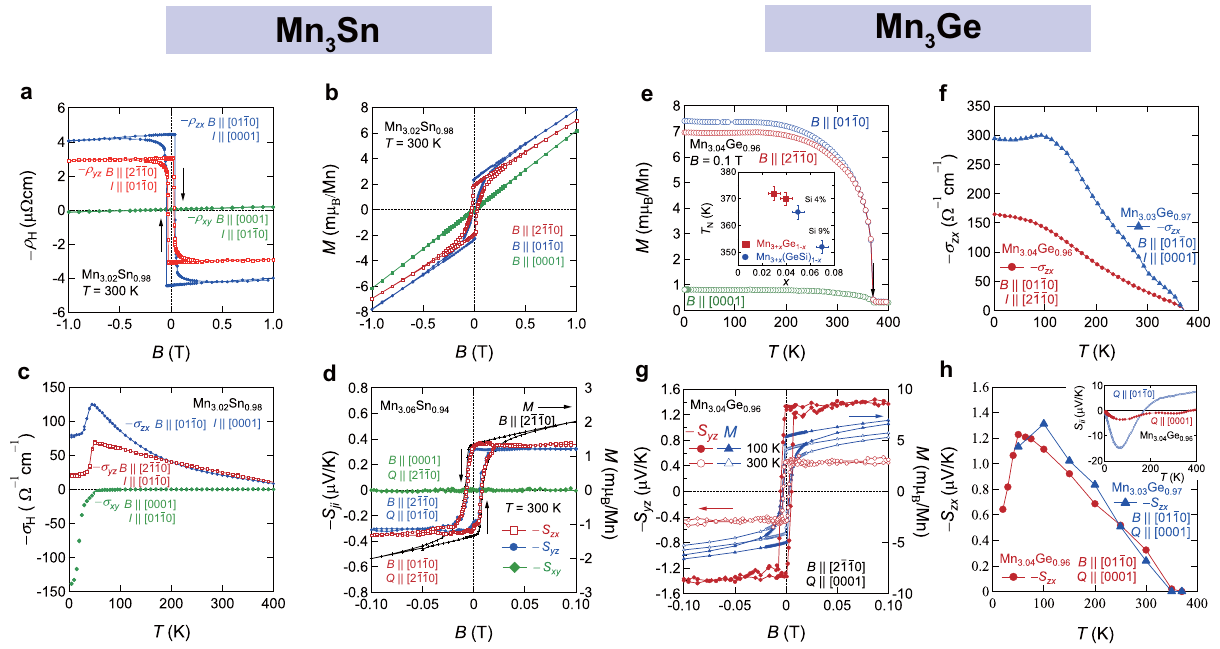
Fig. 2 Observation of large anomalous Hall and Nernst effects in Mn 3 Sn. a Field dependence of the Hall resistivity, ρ H ( B ), observed in Mn 3.02 Sn 0.98 at (cid:1) (cid:3) (cid:1) (cid:3) room temperature under magnetic fi elds B k 2 (cid:1) 1 (cid:1) 10 , 01 (cid:1) 10 , and [0001]. b Anisotropic behavior of the magnetization M of Mn 3.02 Sn 0.98 observed at room temperature for the three different fi eld directions. c Temperature dependence of the zero- fi eld Hall conductivity, σ H ( B = 0), in Mn 3.02 Sn 0.98 . d Anisotropic (cid:1) (cid:3) fi eld dependence of the Nernst coef fi cient − S ji of Mn fi eld dependence of the magnetization M for B k 2 (cid:1) 1 (cid:1) 10 (right axis) is shown (cid:1) 3.06 Sn 0.94 (left axis). The for comparison. e Temperature dependence of the magnetization M of Mn 3.04 Ge 0.96 obtained at B = 0.1 T along 2 (cid:1) 1 (cid:1) 10 respectively. The magnetization is strongly anisotropic, such that the ratio between the in-plane and out-of-plane M reaches about 10 in the low- temperature region. This feature is expected for the coplanar magnetic structure. Inset: the variation of the Néel temperature T N as a function of the Mn concentration x . The red and blue symbols represent T N values obtained in Mn 3 + x Ge 1- x and Mn 3 + x (GeSi) 1- x , respectively. f Temperature dependence of the (cid:1) Hall conductivity, − σ zx , observed in Mn 3.03 Ge 0.97 and Mn 3.04 Ge 0.96 . g Anomalous Nernst coef fi cient, − S yz ( B ) (left axis) vs. B obtained for B k 2 (cid:1) 1 (cid:1) 10 Q || [0001], at 100 and 300 K. The isothermal magnetization M curves (right axis) are also shown at the same temperatures, which exhibit approximately the same coercivity fi eld of about 80 Oe as in − S yz ( B ). h Temperature dependence of the zero- fi eld Nernst coef fi cient, − S zx ( T ), for Mn 3.03 Ge 0.97 and (cid:1) (cid:3) Mn 3.04 Ge 0.96 obtained in fi eld sweep measurements. Inset: Seebeck coef fi cients S yy ( T ) ( Q k 01 (cid:1) 10 ) and S zz ( T ) ( Q || [0001]) of Mn 3.04 Ge 0.96 as a function of T measured under zero fi eld. Both S yy ( T ) and S zz ( T ) retain negative values at low temperatures, and S yy ( T ) exhibits a pronounced negative peak at about 60 K. Adapted from ref. 4 , Springer Nature ( a – c ) and ref. 9 , Springer Nature ( d